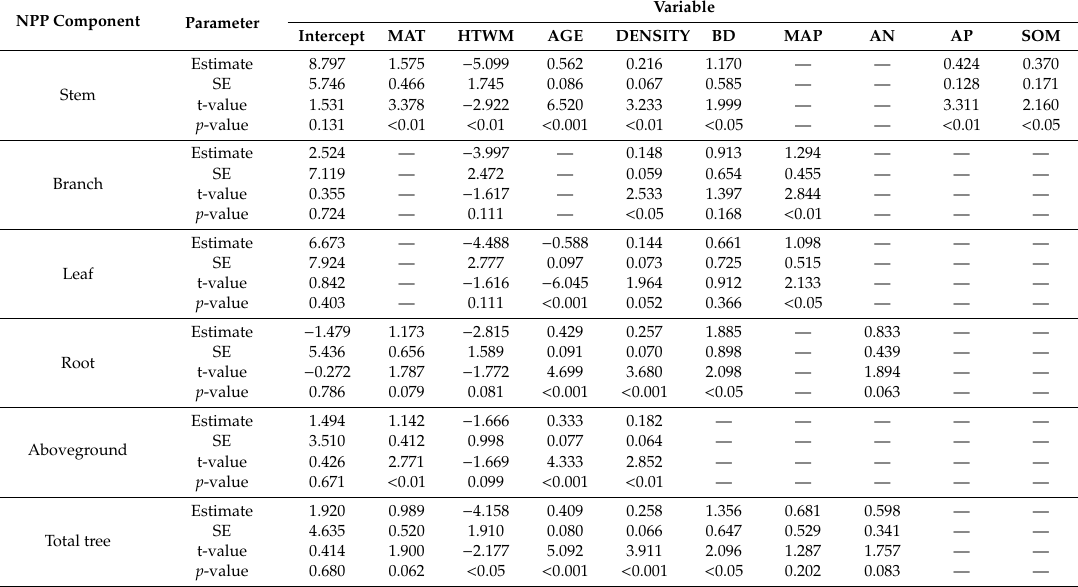
Table 3. Summary of the final model to test the e ff ects of environmental factors and stand characteristics on P. massoniana stem, branch, leaf, root, aboveground, and total tree net primary productivity (NPP). Only the best-performing model, with the lowest the Akaike Information Criterion corrected for small samples (AICc), is shown (see Table S2 for the results of model performance).